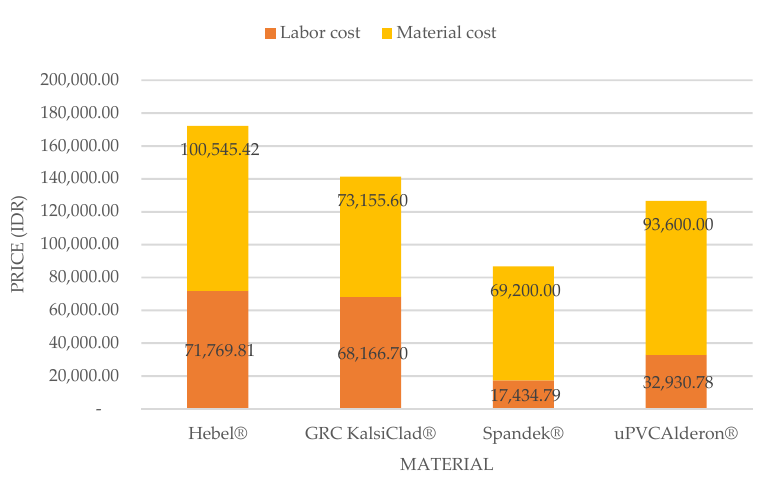
Figure 7. Cost comparison between material and labor cost of construction with four materials. The significant difference in the total price of the wall cladding work occurred due to the low labor costs of several materials. In Figure 7, the low cost of Spandek ® work was due to the low percentage of wages at only 20% (17.424 IDR/m 2 ) of the total price of the work when compared to material costs of 69.200 IDR/m 2 (80%). Likewise, the labor wage for Alderon RS ® ’s work was only 26% (32.930 IDR/m 2 ) of the total price of the work when compared to material costs of 93.600 IDR/m 2 (74%). Hebel ® (40%) and KalsiClad ® wages (48%) were a fairly large percentage of the wage price, making the total price more